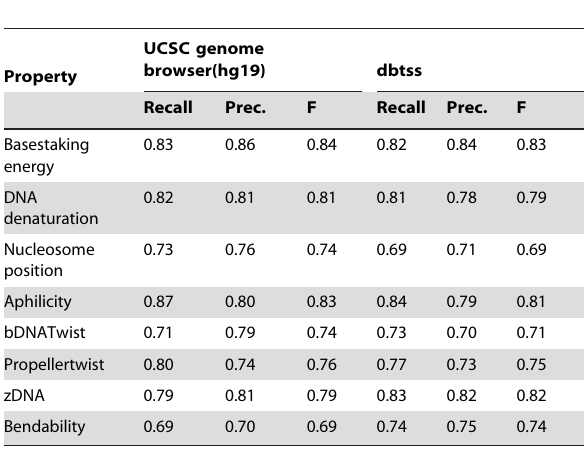
Figure 5. Structural pattern of eight different features for the sequences taken from UCSC table browser of hg19 human genome. The sequences used here are not generated by grammars. The structural profiles are plotted with average value of window size 3 nt. doi:10.1371/journal.pone.0054843.g005 Table 5. Performance of grammar rule along with eight structural features of DNA on two